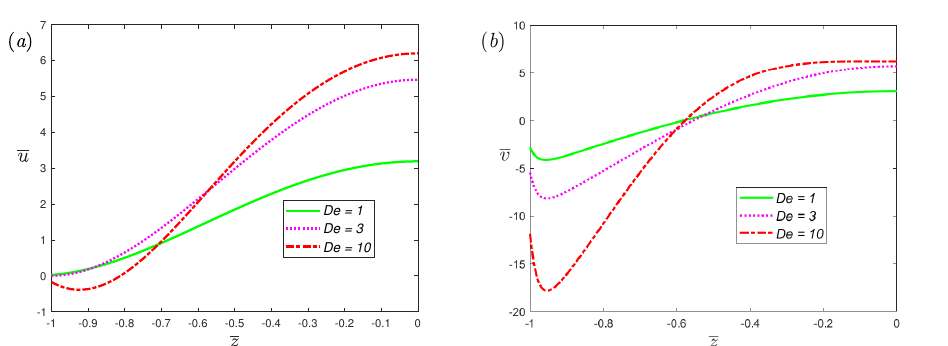
Figure 5. The dimensionless velocity, ( a ) spanwise; ( b ) streamwise, profiles of fractional Maxwell model across half channel width for different dimensionless parameters K at t = π /3, α = 0.7, β = 1, De = 5, L = 0.03, ω = 2, Ha = 0.5.